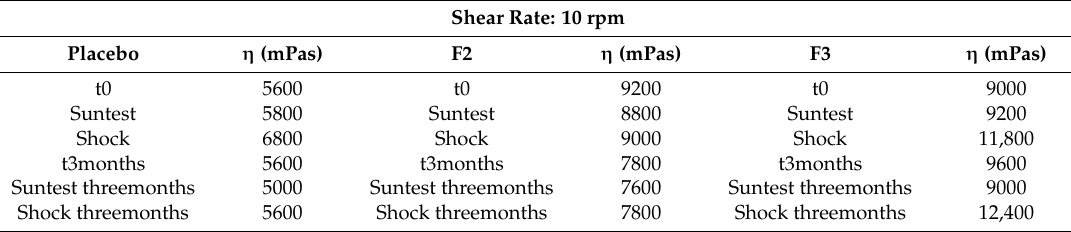
Table 9. Viscosity values of formulations before and after treatments and after three months. Shear Rate: 10